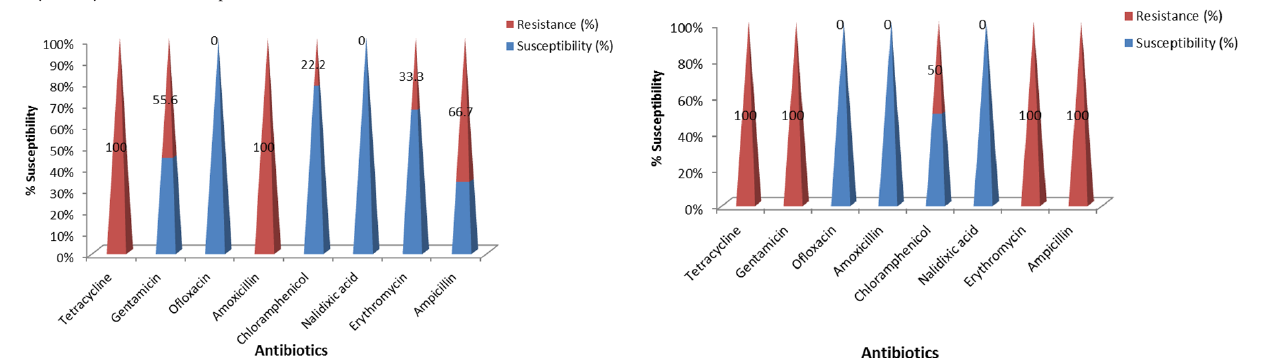
Fig. 4. Antibiogram of E. coli O157:H7 isolated from cow dung used to fertilize fish ponds in New Bussa Nigeria